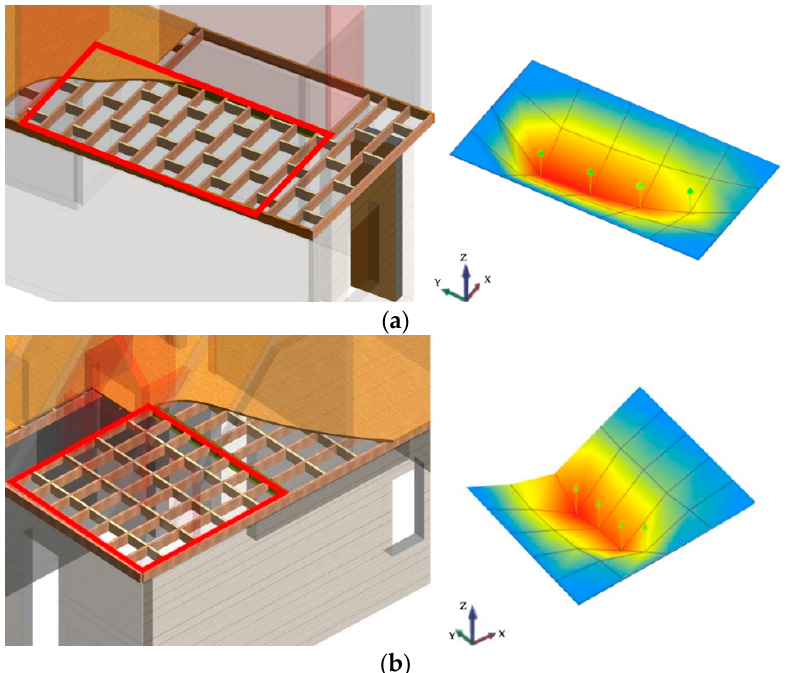
Figure 12. Measured fundamental vibration mode for: ( a ) Lab-2.4-W floor (26.45 Hz Enhanced Frequency Domain Decomposition (EFDD) method); ( b ) Field-3.1-W (16.38 Hz EFDD method). Extracted form ARTeMIS Modal Pro [21].